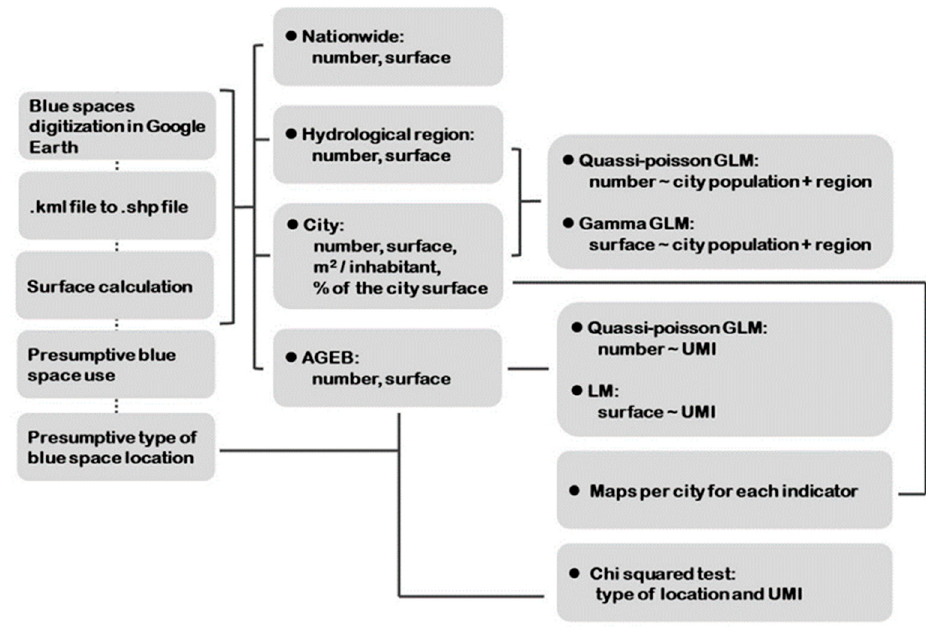
Figure 2. Procedure for lacustrine blue spaces delimitation and indices estimation.